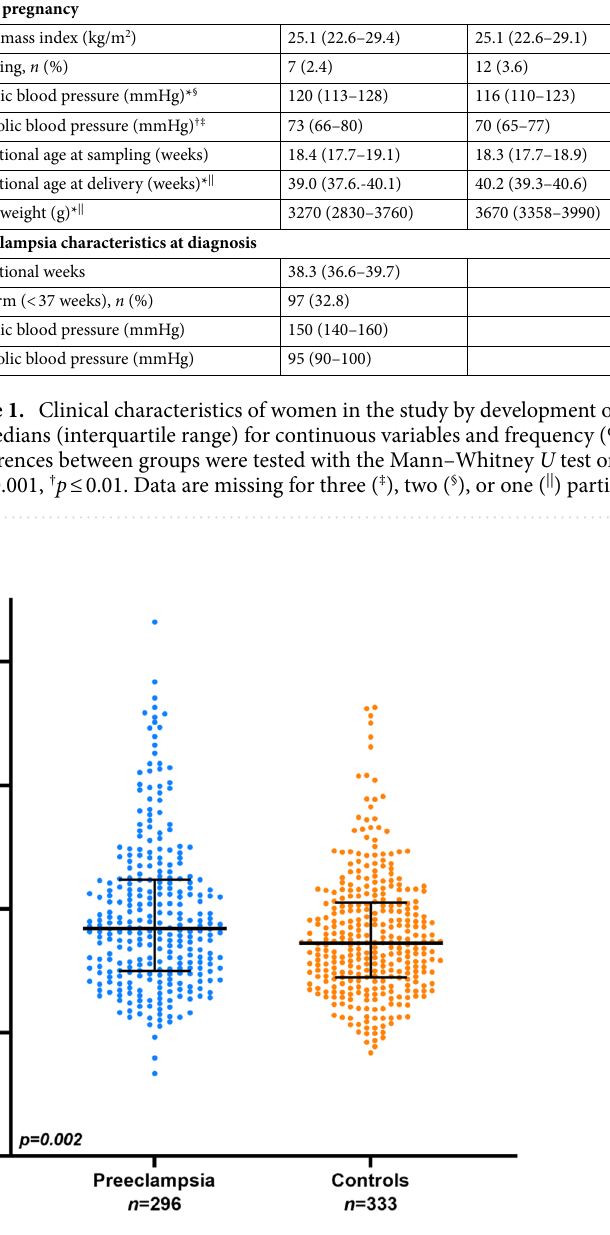
Figure 1. Relative circulating levels of angiotensin-converting enzyme 2 (ACE2) in mid-pregnancy. Horizontal lines represent medians and the interquartile range of ACE2 levels, p = 0.002 (Mann–Whitney U